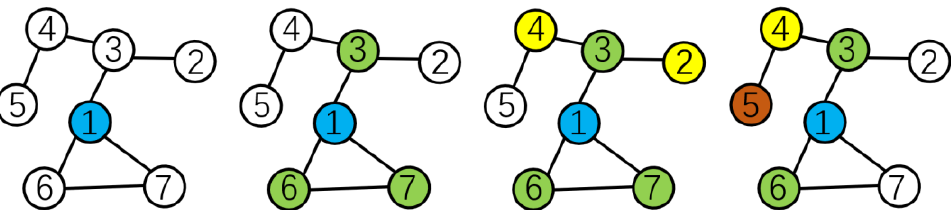
Figure 2. The picture shows the propagation process of a node. In the first step, node 1 propagates one step and finds 3, 6, and 7. In the second step, it propagates two steps and finds 4 and 2. In the third step, it propagates three steps. Then, 5 is found, but, at this time, the adaptive stop propagator of nodes 2 and 7 stops the propagation of nodes 2 and 7, so the features of these two nodes should be removed in this